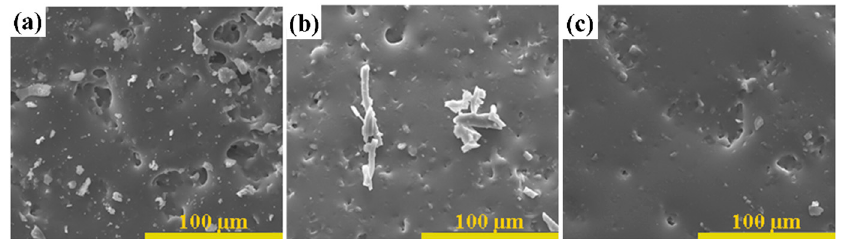
Figure 6. Surface micromorphology of coatings inserted at varied temperatures: ( a ) 900 °C; ( b ) 1100 °C; ( c ) 1150 °C. Sintering parameters: Heating rate: 3 °C/min, sintering temperature: 1200 °C, holding time: 0.5 h, and cooling down with the furnace.